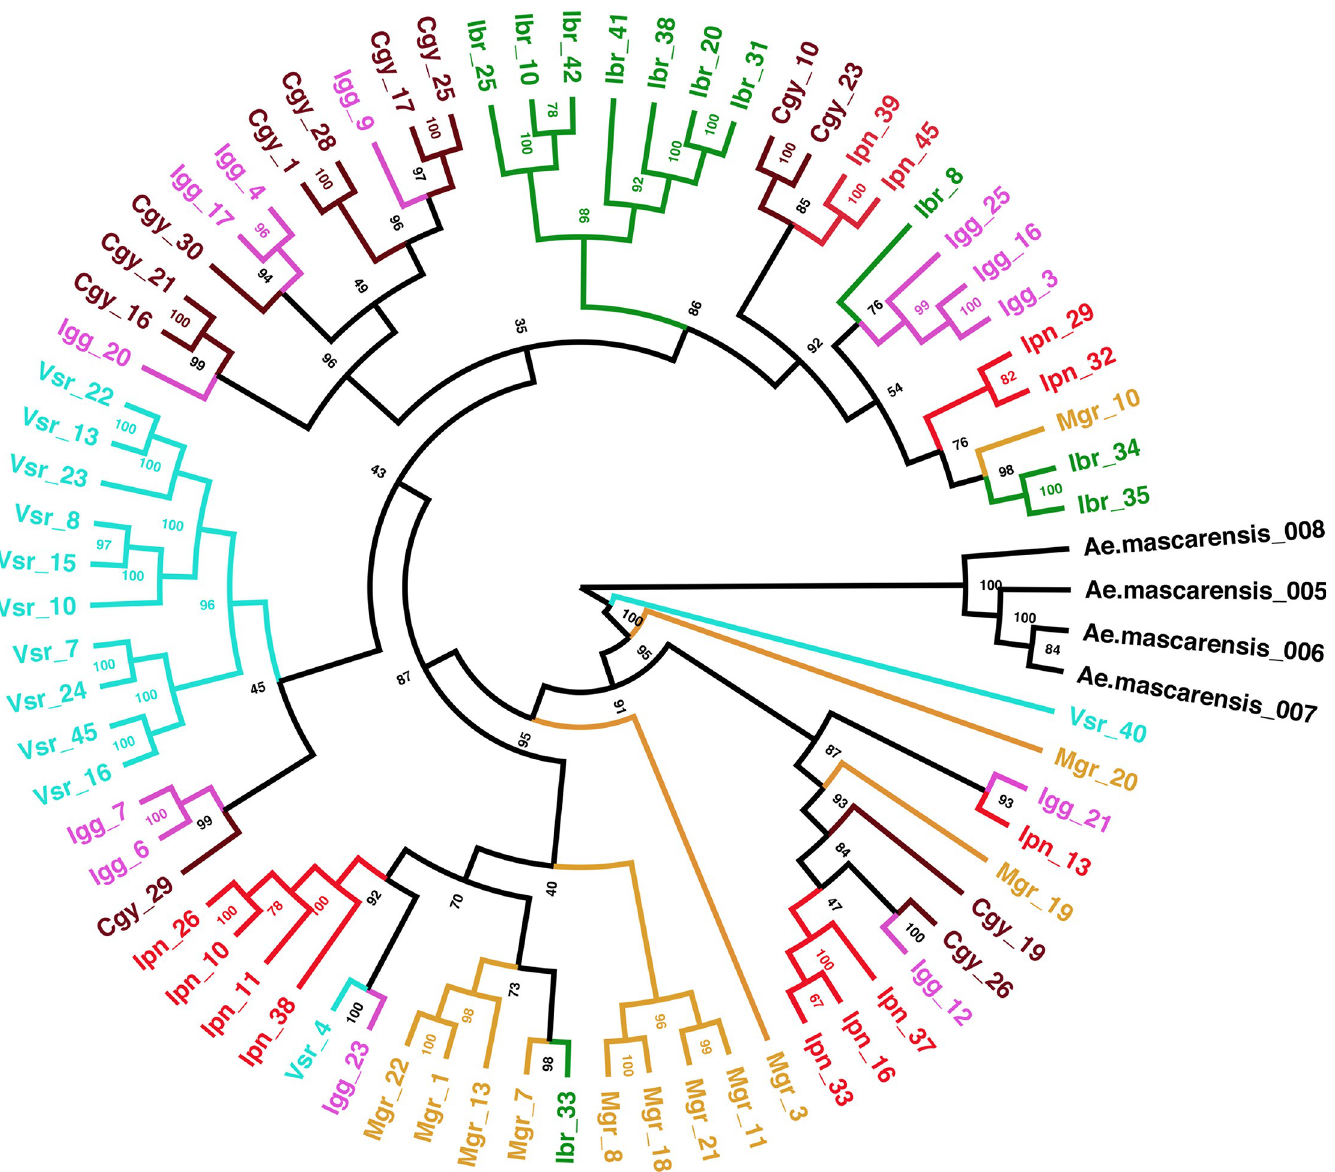
Fig 8. Phylogeny of the Rio de Janeiro mosquitoes generated in IQTree. We developed the tree with 16,596 SNP loci. We used four Ae . mascarensis samples as the outgroup. The number on each node indicates the support level estimated by 1000 ultrafast bootstraps.